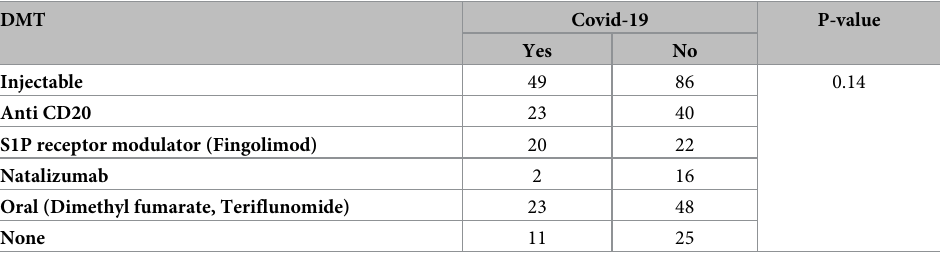
Table 7. Type of DMT and getting COVID- 19 in each